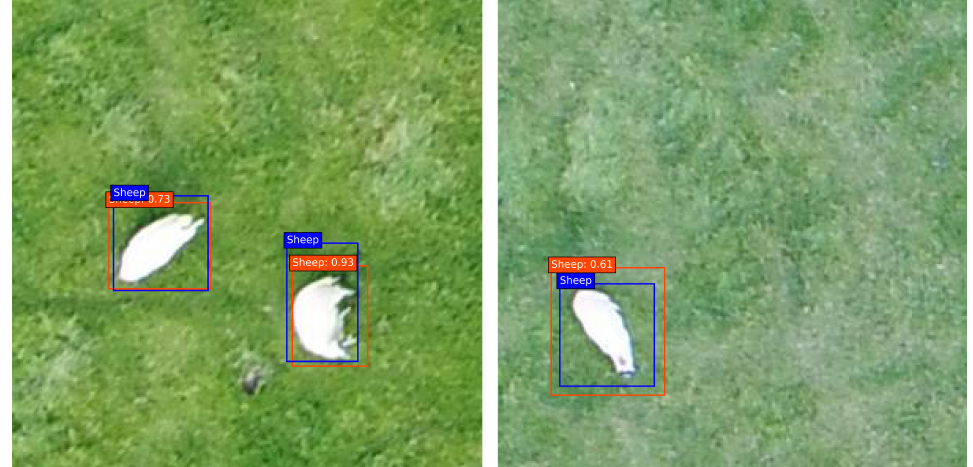
Figure 11. Qualitative evaluation of bounding box predictions by the proposed network on custom livestock dataset. Blue boxes correspond to the ground truth label and red boxes are the predicted bounding